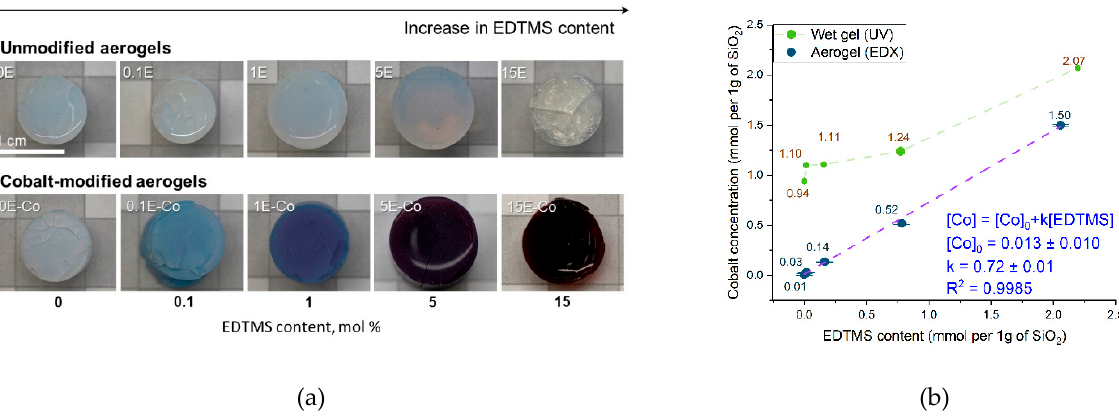
Figure 2. ( a ) Appearance of the prepared aerogels. ( b ) Control of cobalt concentrations by varying EDTMS content in the obtained wet gels (from UV-vis) and aerogels (from EDX). In turn, all the cobalt-containing aerogels ( E-Co ) were violet in color, with coloration increasing with the corresponding increase in the EDTMS content in the gels (Figure spectroscopy (Figure 3). The absorption of the samples containing no cobalt ions ( E series)